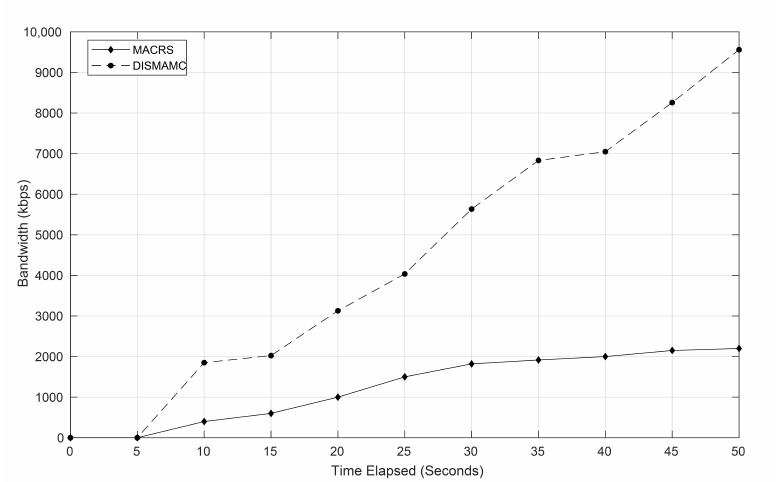
Figure 15. Network bandwidth